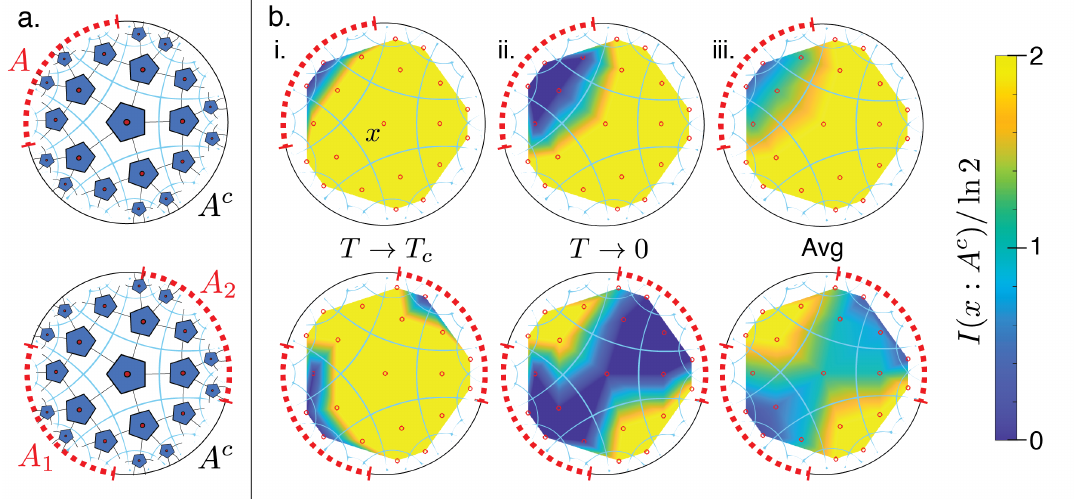
Figure 14 . Bulk information retained by the M = 1 HaPPY code (a) after projectively measuring (dotted red) a single contiguous region A (top row) or a pair of diametrically opposed regions A = A 1 ∪ A 2 (bottom row) in local Clifford bases. Colormaps (b) show mutual information I ( x : A c ) between each bulk qubit x ∈ b (red circles) and the remaining boundary region A c (solid black). By searching over local measurement bases on A , we can find the least destructive (i) or most destructive (ii) measurement basis, which mimic holographic ETW brane geometries with brane tension varying from nearly critical T → T to nearly vanishing T → 0 , respectively. The average mutual information c (iii), sampled over 100 random choices of local boundary measurements, suggests that most choices of measurement lead to low-tension ETW branes extending deep into the bulk. The HaPPY code we implement here encodes N = 55 boundary qubits into b = 21 bulk qubits, with | A | = 16 for the contiguous region (top) and | A = | A = 15 for the pair of opposing regions 1 | 2 |